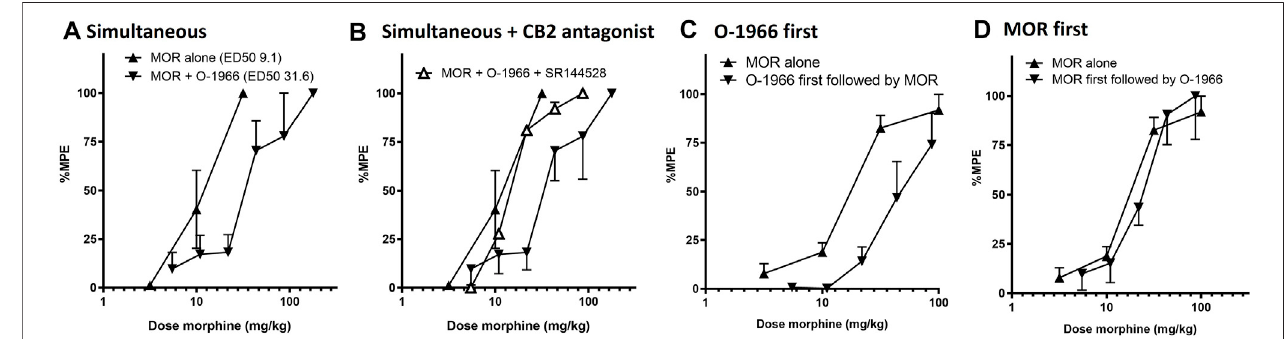
FIGURE3| OrdereffectofmorphineandO-1966incombinationonantinociceptionasmeasuredbywithdrawallatencyona54 ° Chotplate.MorphineandO-1966 were either administered simultaneously (A) , simultaneous with SR144528 (B) , O-1966 15 min prior to morphine (C) , or morphine 15 min prior to O-1966 (D) . X-axis: